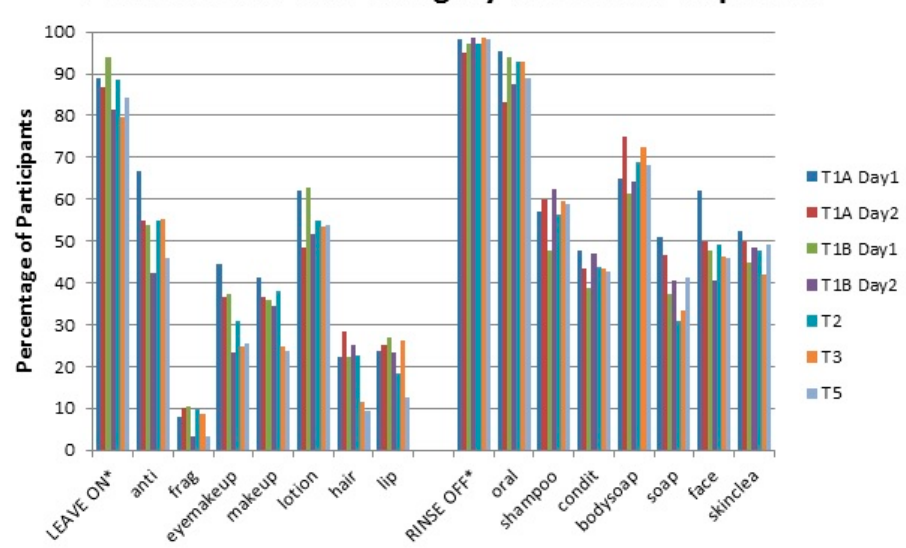
Figure 4. Prevalence of product use categories by study time period. See Table 1 for category definitions.